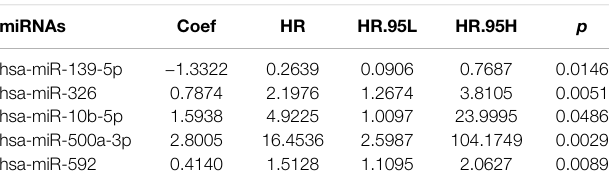
TABLE 2 | Results of multivariate Cox regression in 5-necroptosis-related miRNAs. miRNAs Coef HR HR.95L HR.95H p